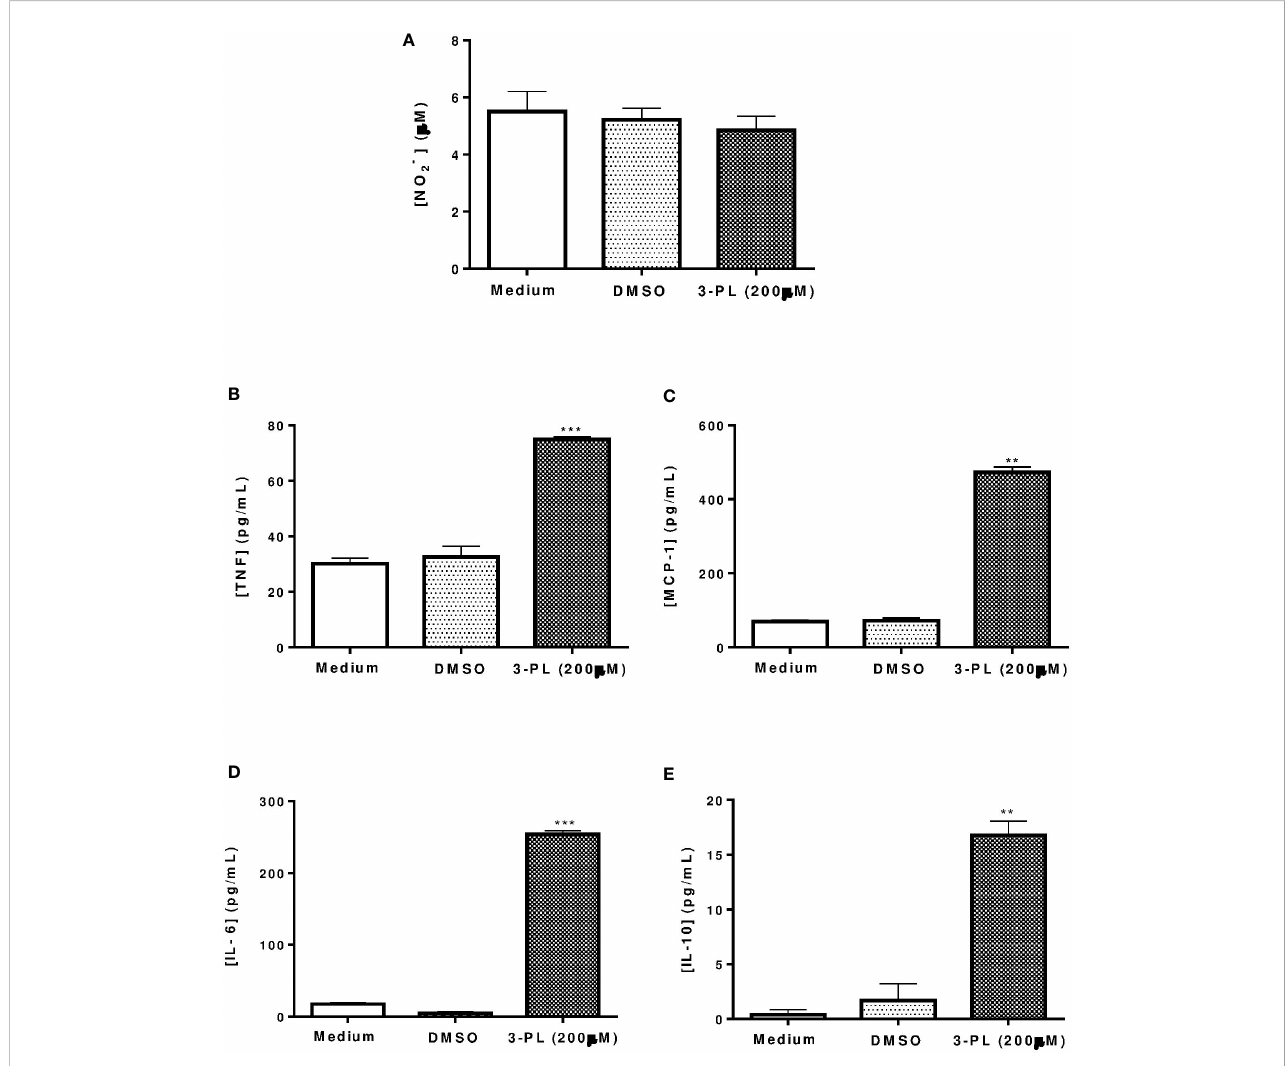
FIGURE 2 Production of nitric oxide and cytokines by infected macrophages treated with 3-PL. The mediators were measured in the supernatant of macrophages infected with L. ( V. ) braziliensis after 48h of treatment with 200 µM 3-PL. (A) Nitric oxide concentration was evaluated by the Griess method. (B-E) Cytokines TNF- a , MCP-1, IL-6 and IL-10 were measured by the Cytometric Bead Array (CBA) method. The data of nitrite (µM) and cytokines (pg/mL) concentration were expressed as the means ± SD, (n=3). **p < 0.01 and ***p < 0.001 in relation to control